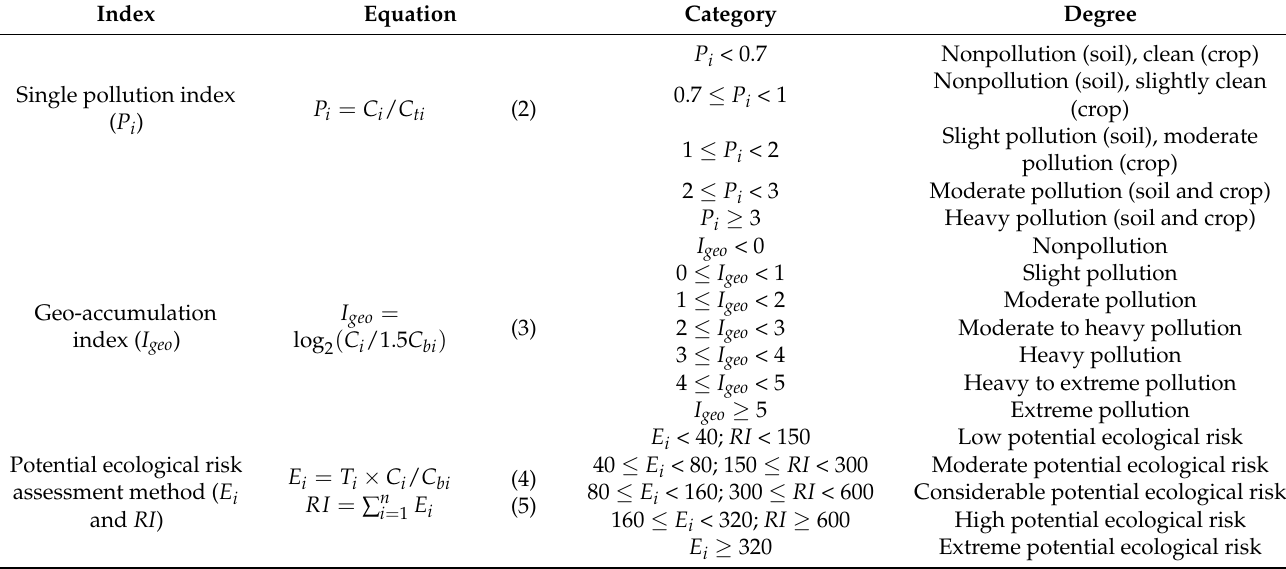
Table 1. Classification of P i , I geo , E i and RI .